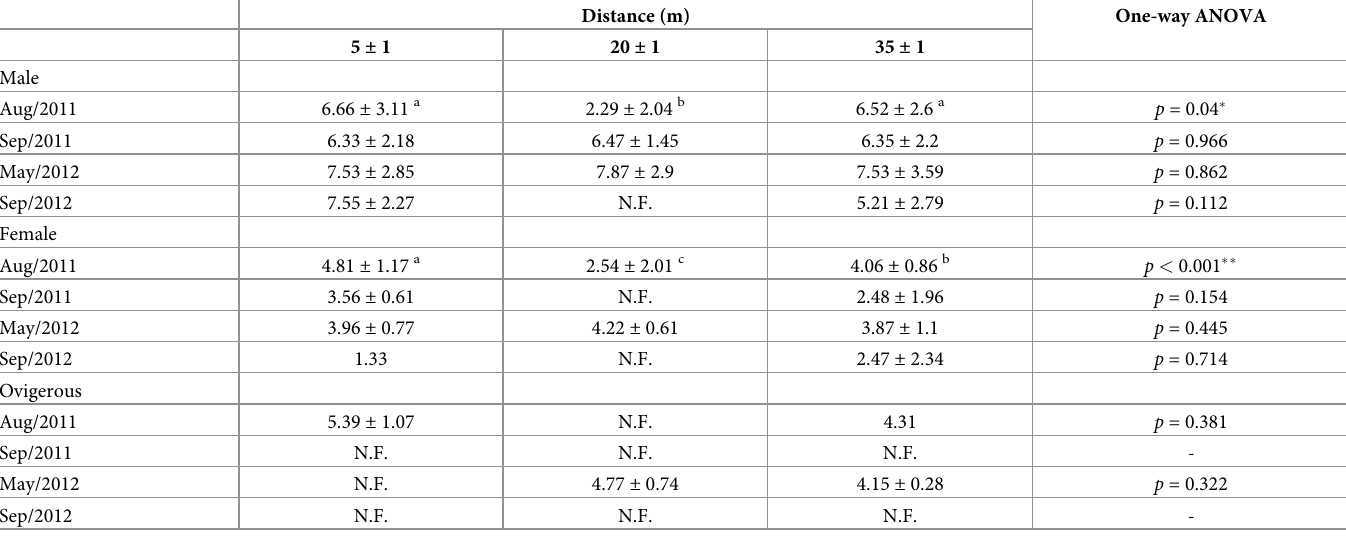
Table 2. Body weight (g) (mean ± standard variation) of male, female and ovigerous Xenograpsus testudinatus , and the statistical results of one-way ANOVA (between groups) of three sampling distances.